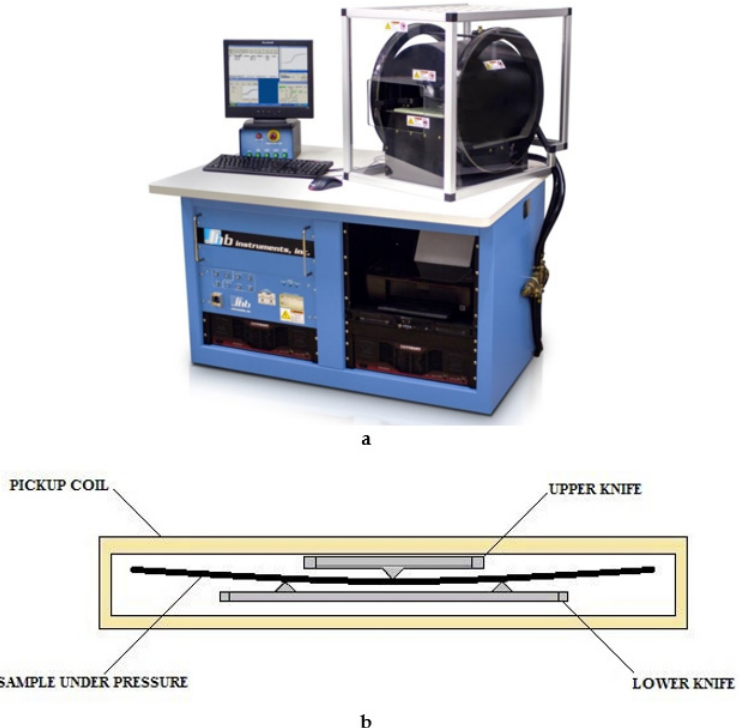
Figure 1. ( a ) Equipment MESA-200. ( b ) Schematic representation of a block for creating mechanical stresses on a plate on the MESA-200 equipment.